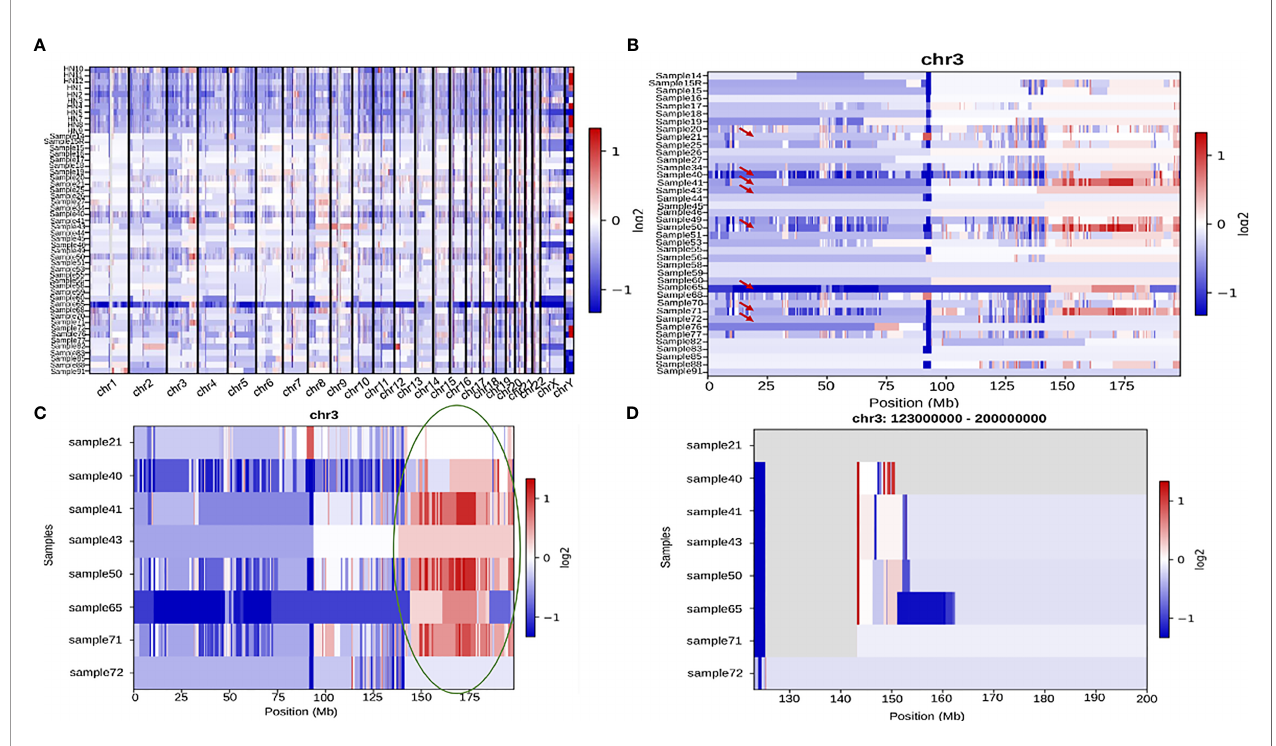
FIGURE 9 | (A) A comprehensive heatmap showing copy number variation in all the samples across all the chromosomes. (B) Heatmap showing copy number variation across the entire length of chr3 in all the samples. Samples 21, 40, 41, 43, 50, 65, 71, and 72 are indicated by a red arrow since they show the most signi fi cant amount of variation amongst all the 41 samples. (C) A heatmap representing the above-mentioned subset of samples with a high amount of variation towards the end of chromosome 3. The last ~70 Mb (150Mb-200Mb) have been highlighted with a green oval which have been zoomed into in (D)